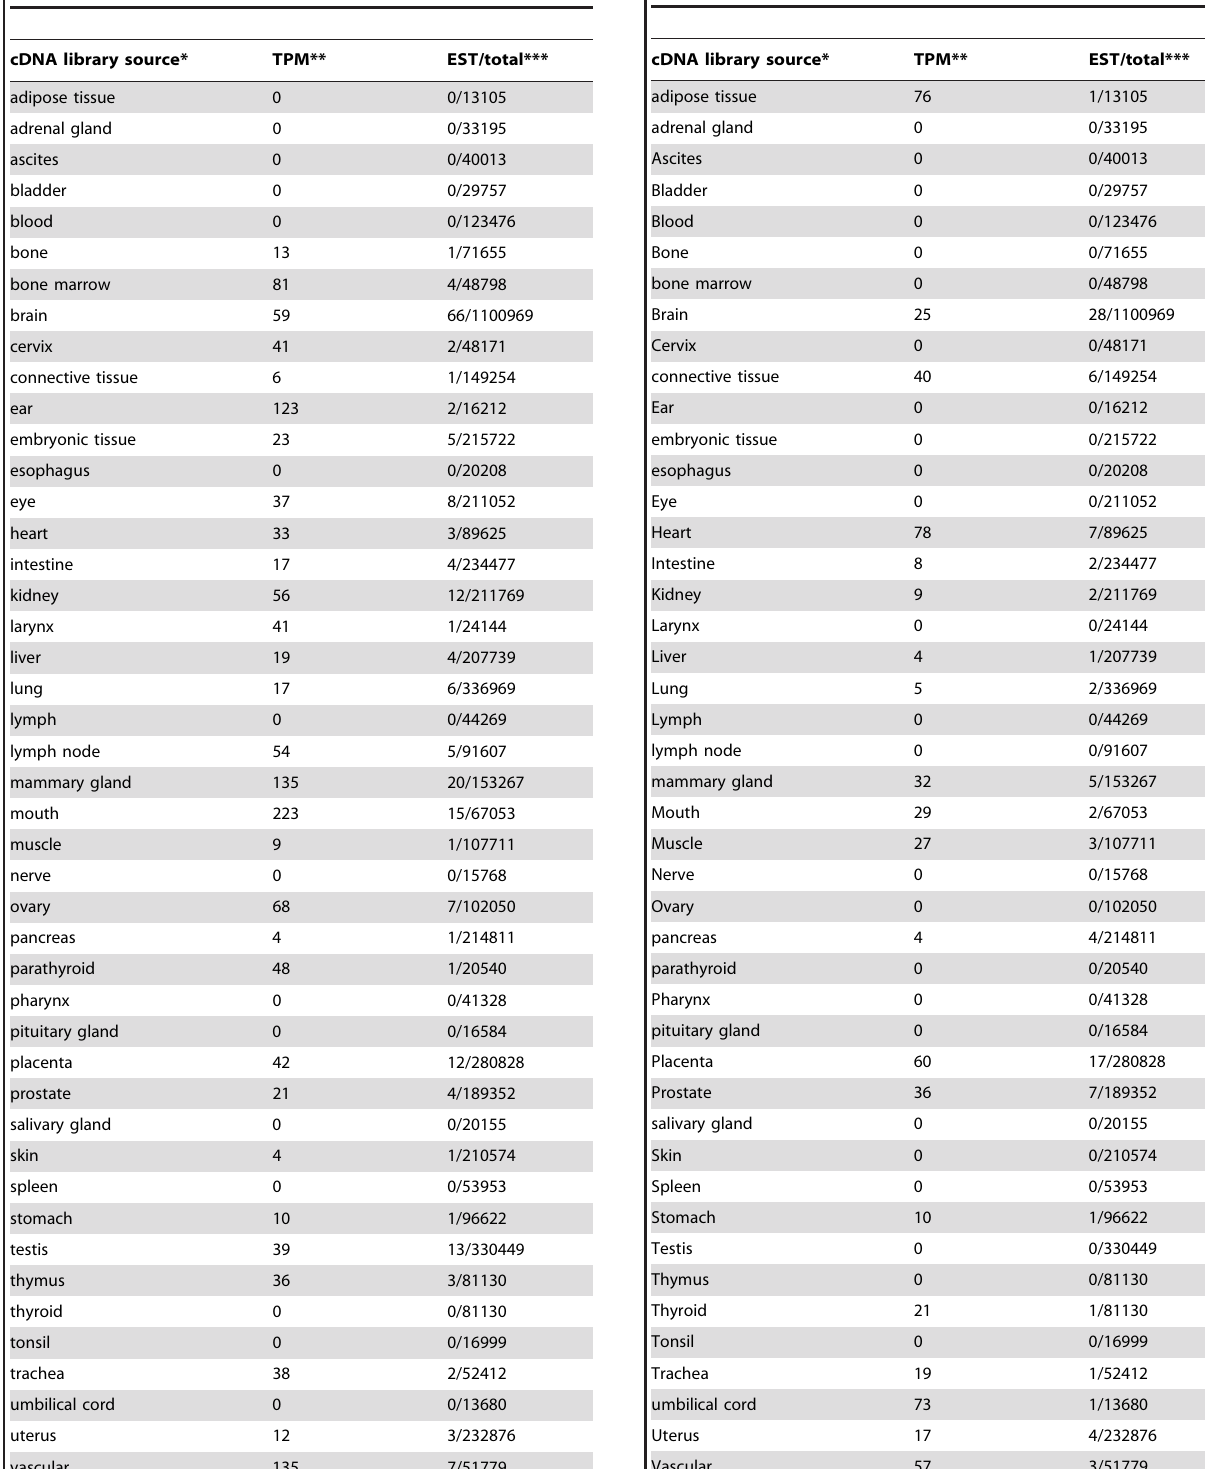
Table 3. EST profiles of DIA1R gene expression in human